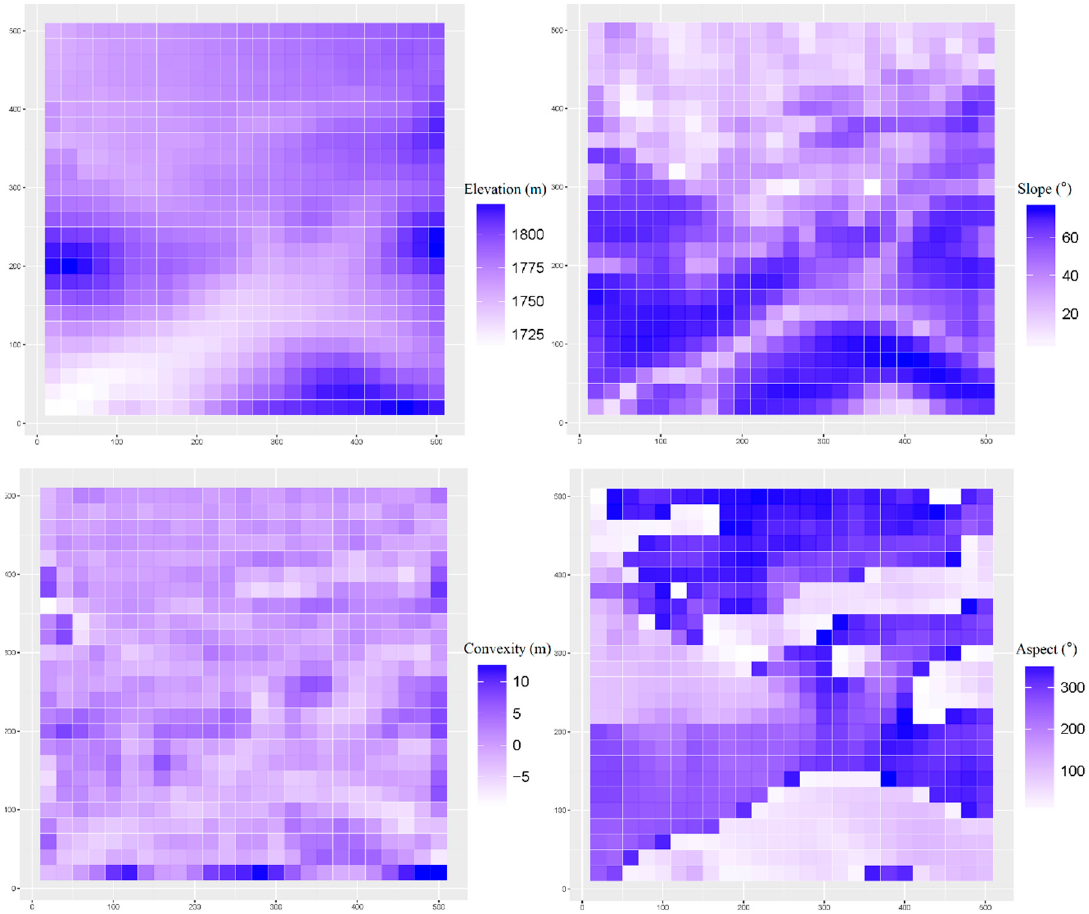
Figure 2. Maps describing the four topographic variables at the scale of 20 m × 20 m in the 25-ha permanent forest dynamics plot in the Qinling Mountains of north-central